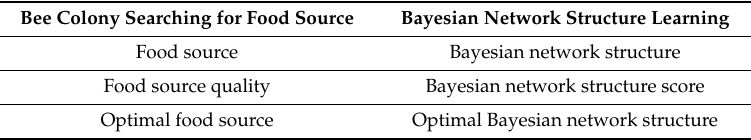
Table 1. Artificial bee colony optimization and structure